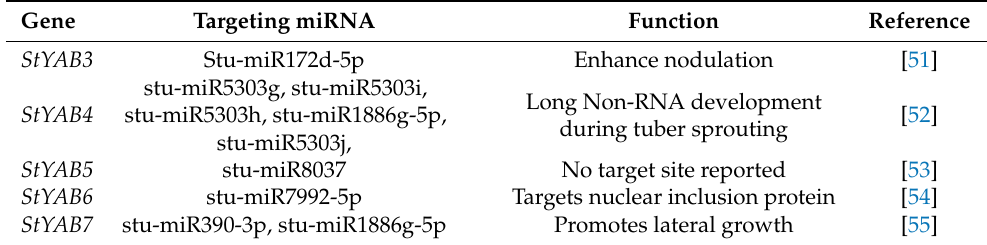
Table 3. StYAB genes targeting putative miRNA functions along with their targeted genes.